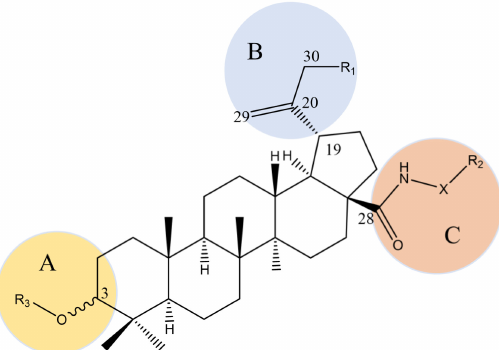
Figure 5. Structure–activity relationships of BA derivatives against HIV. A: 1. Activity disappears after introduction of fluorine at the C-2 position, and the proton at the C-2 position may play a key role in anti-HIV activity. 2. 3- β configuration is better than 3- α configuration. 3. The position of the dimethyl substitution on the side chain greatly influences activity. 4.The activity of the C-3 ester group is replaced by the bioisostere amide. B: 1. The isopropenyl group at position C-19 may not be an active pharmacophore, but proper modification can improve the water solubility of the drug, and thereby improving the pharmacokinetic properties of the drug. 2. R 1 as a hydrogen bond donor is unfavorable to the activity. 3. Changing the C-30 allyl group has no obvious effect on drug activity. C: 1. C-3 acylation can inhibit HIV maturation and C-28 amidation can prevent HIV from integrating into cell membranes. 2. The atomic length of the side chain at position C-28 is extremely significant for improving the antiviral efficacy, and the side chain structure containing amide groups is very important for activity. 3. The free hydroxyl group of R 3 and the free carboxyl group at the end of R 2 are necessary for anti-HIV activity. 4. When X is a secondary amine ring such as piperidine, it can significantly improve metabolic stability.